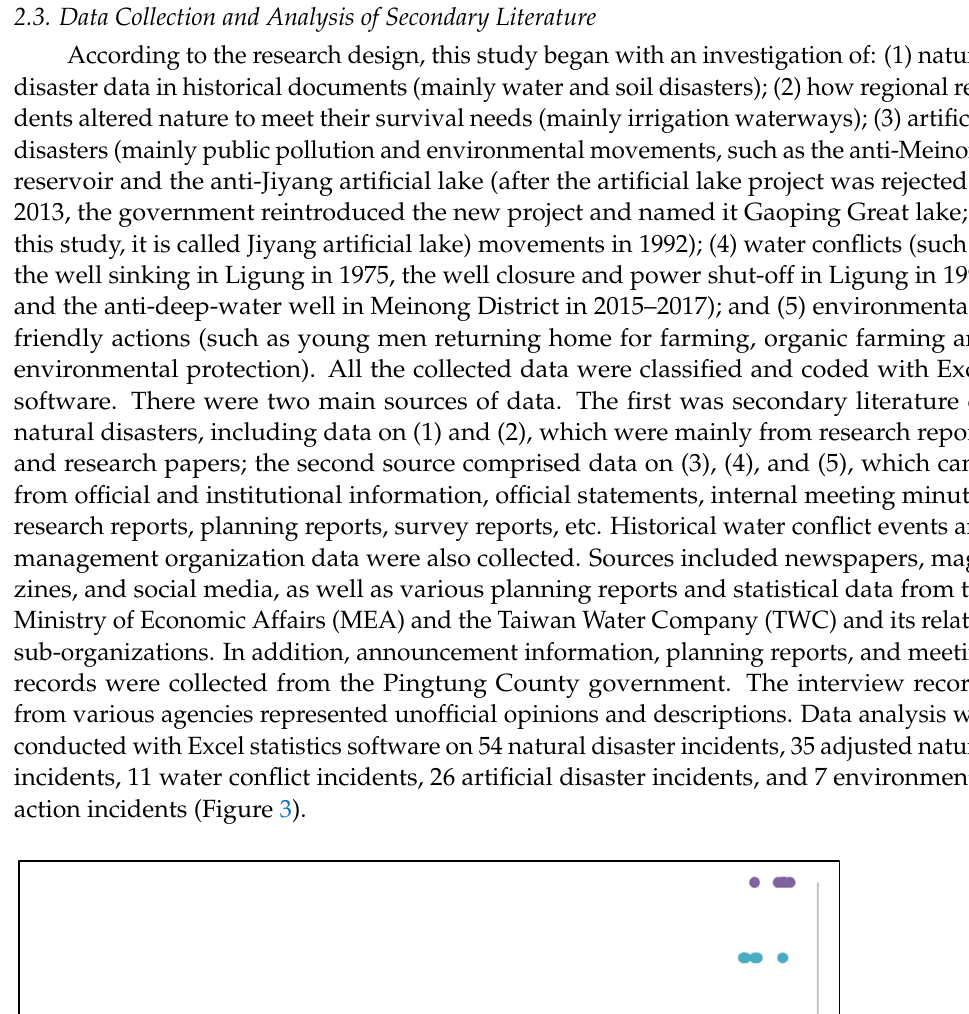
Table 2. Basic descriptions of five study cases.